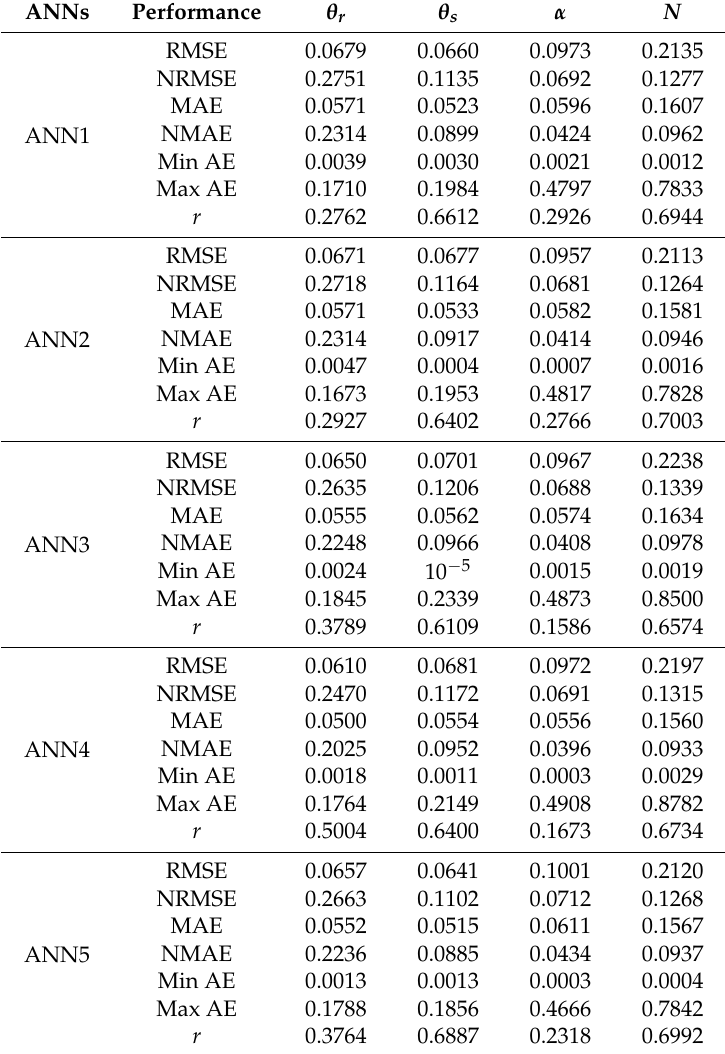
Table 4. Statistical indicators of ANN performance in modeling the test